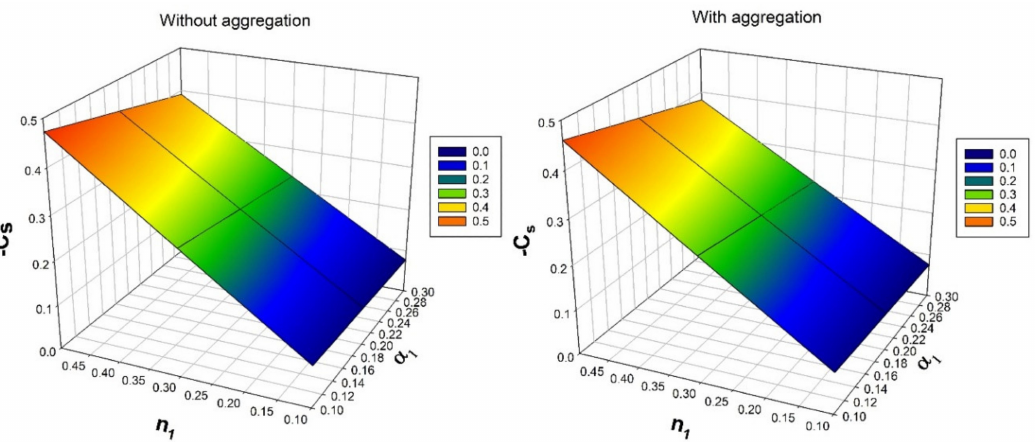
Figure 7. Nature of Skin friction ( − Cf ) over Micropolar parameter ( α 1 ) for numerous values of porous parameter ( β ) .